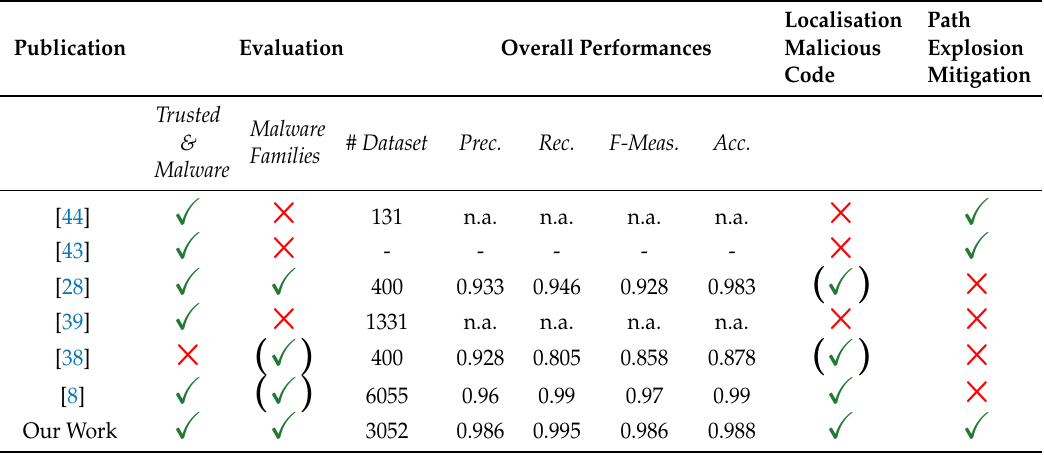
Table 6. Comparison with related works; the ticks in the bracket for the “Malware Families” and “Localisation malicious code” columns refer, respectively, to the few numbers of families evaluated and to the localization to a higher level than method code (for instance, to class